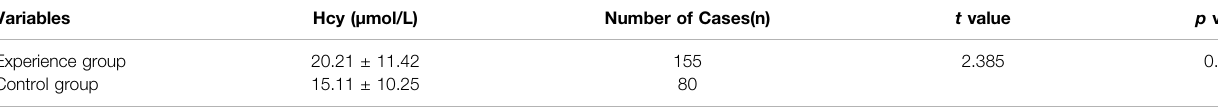
TABLE 2 | Comparison of serum Hcy levels between experimental group and control group. Variables